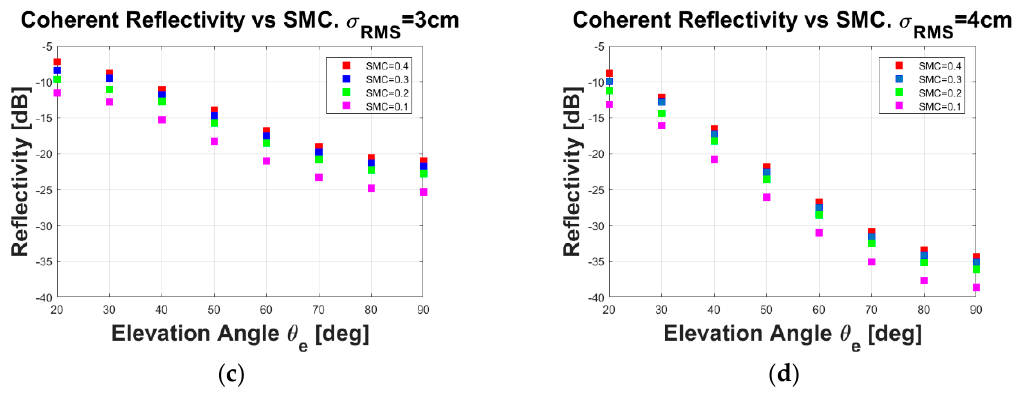
Figure 1. Theoretical prediction of coherent reflectivity Γ LHCP,coh as a function of the elevation angle θ e for different levels of soil moisture content (SMC) and surface roughness: ( a ) σ RMS = 1 cm, ( b ) σ RMS = 2 cm, ( c ) σ RMS = 3 cm, and ( d ) σ RMS = 4